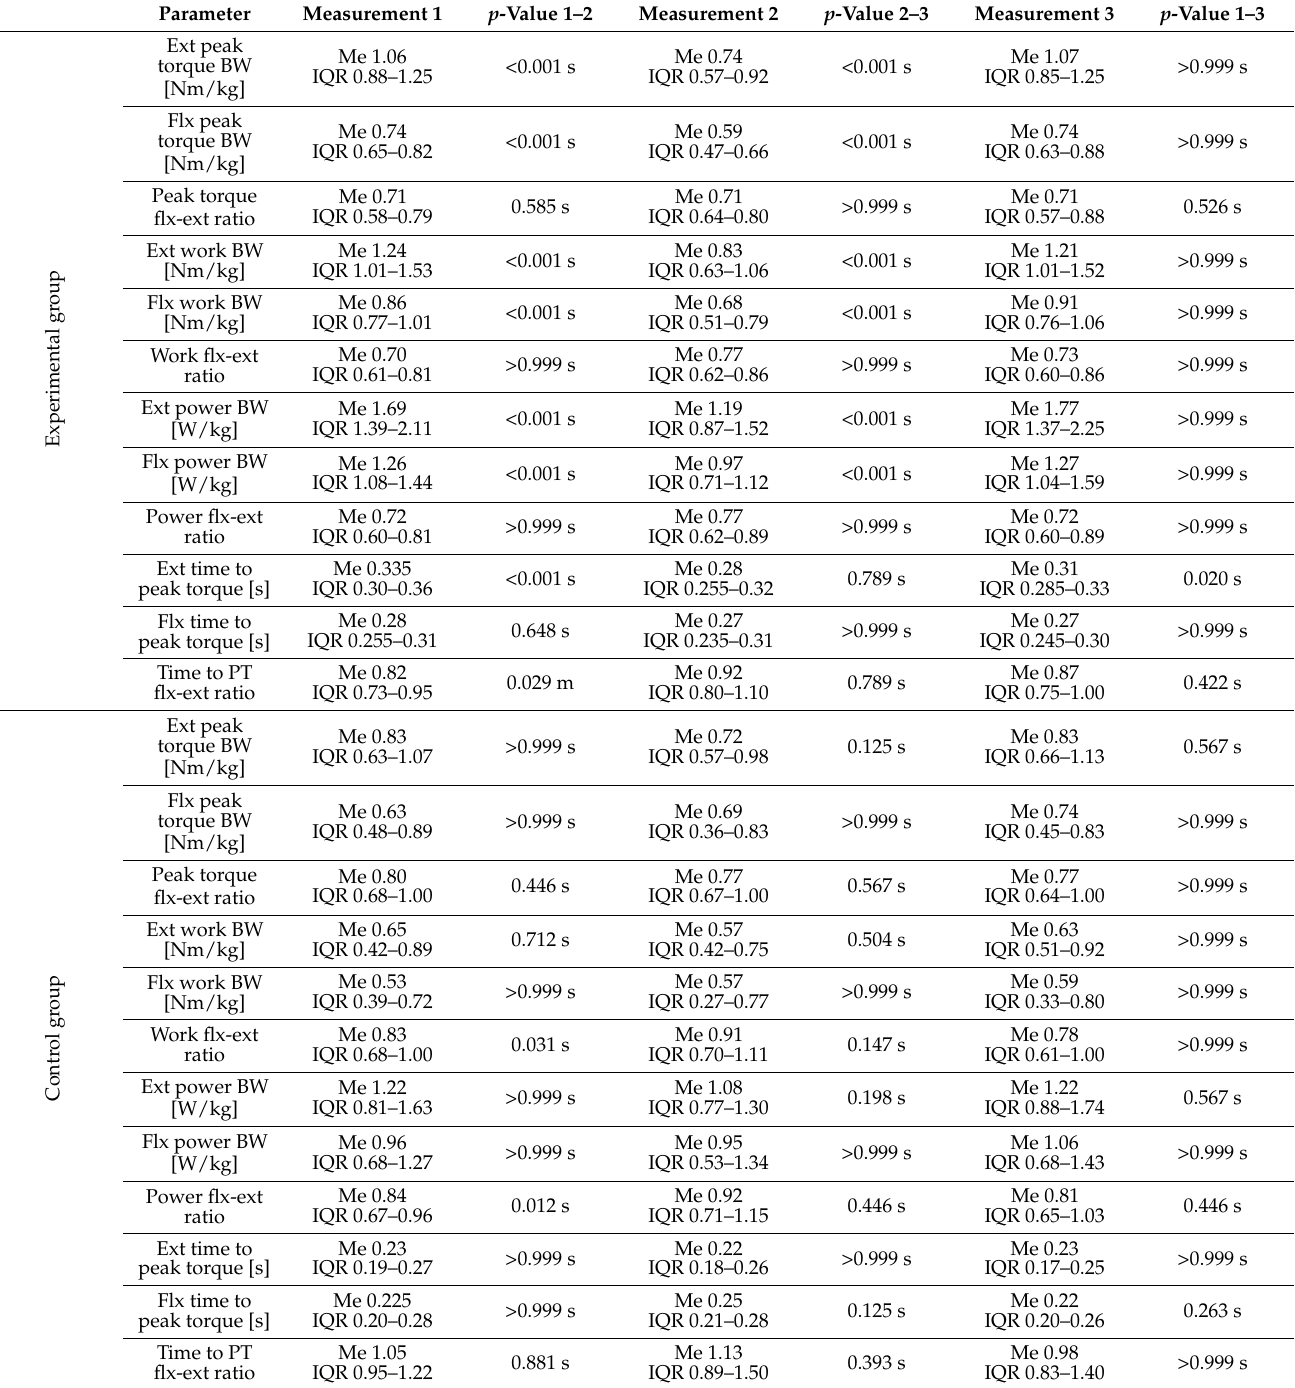
Table A3. Results of measurement in the 180 ◦ /s test for the experimental and control groups, where: s—means small, m—medium and l—large effect size calculated by Cohen’s